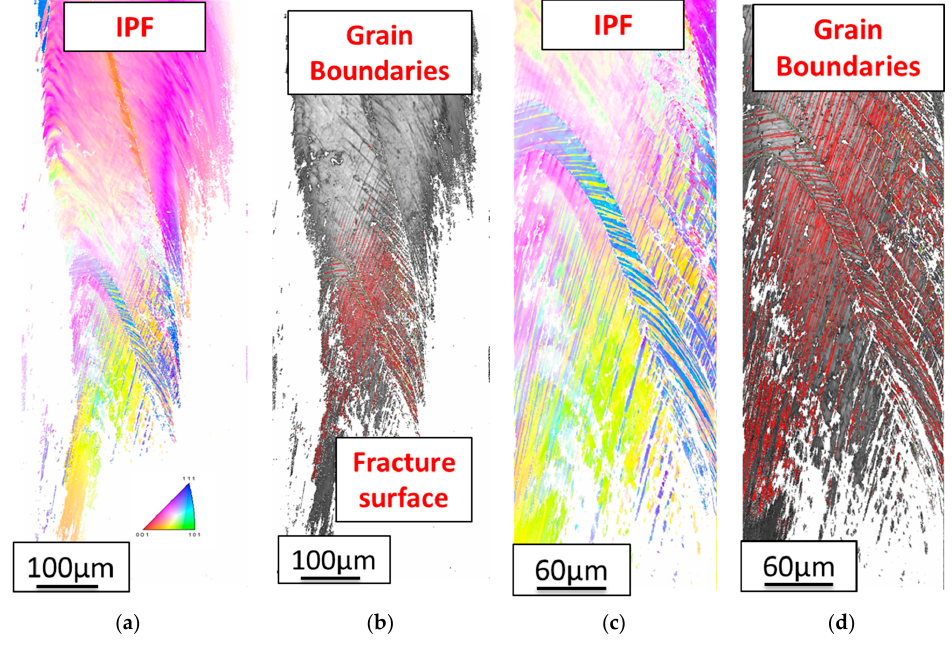
Figure 9. ( a ) Inverse pole figure mapping (magnification ( c )) and ( b ) image quality mapping with grain boundaries of a broken solution annealed oligo-crystalline wire (magnification ( d )).